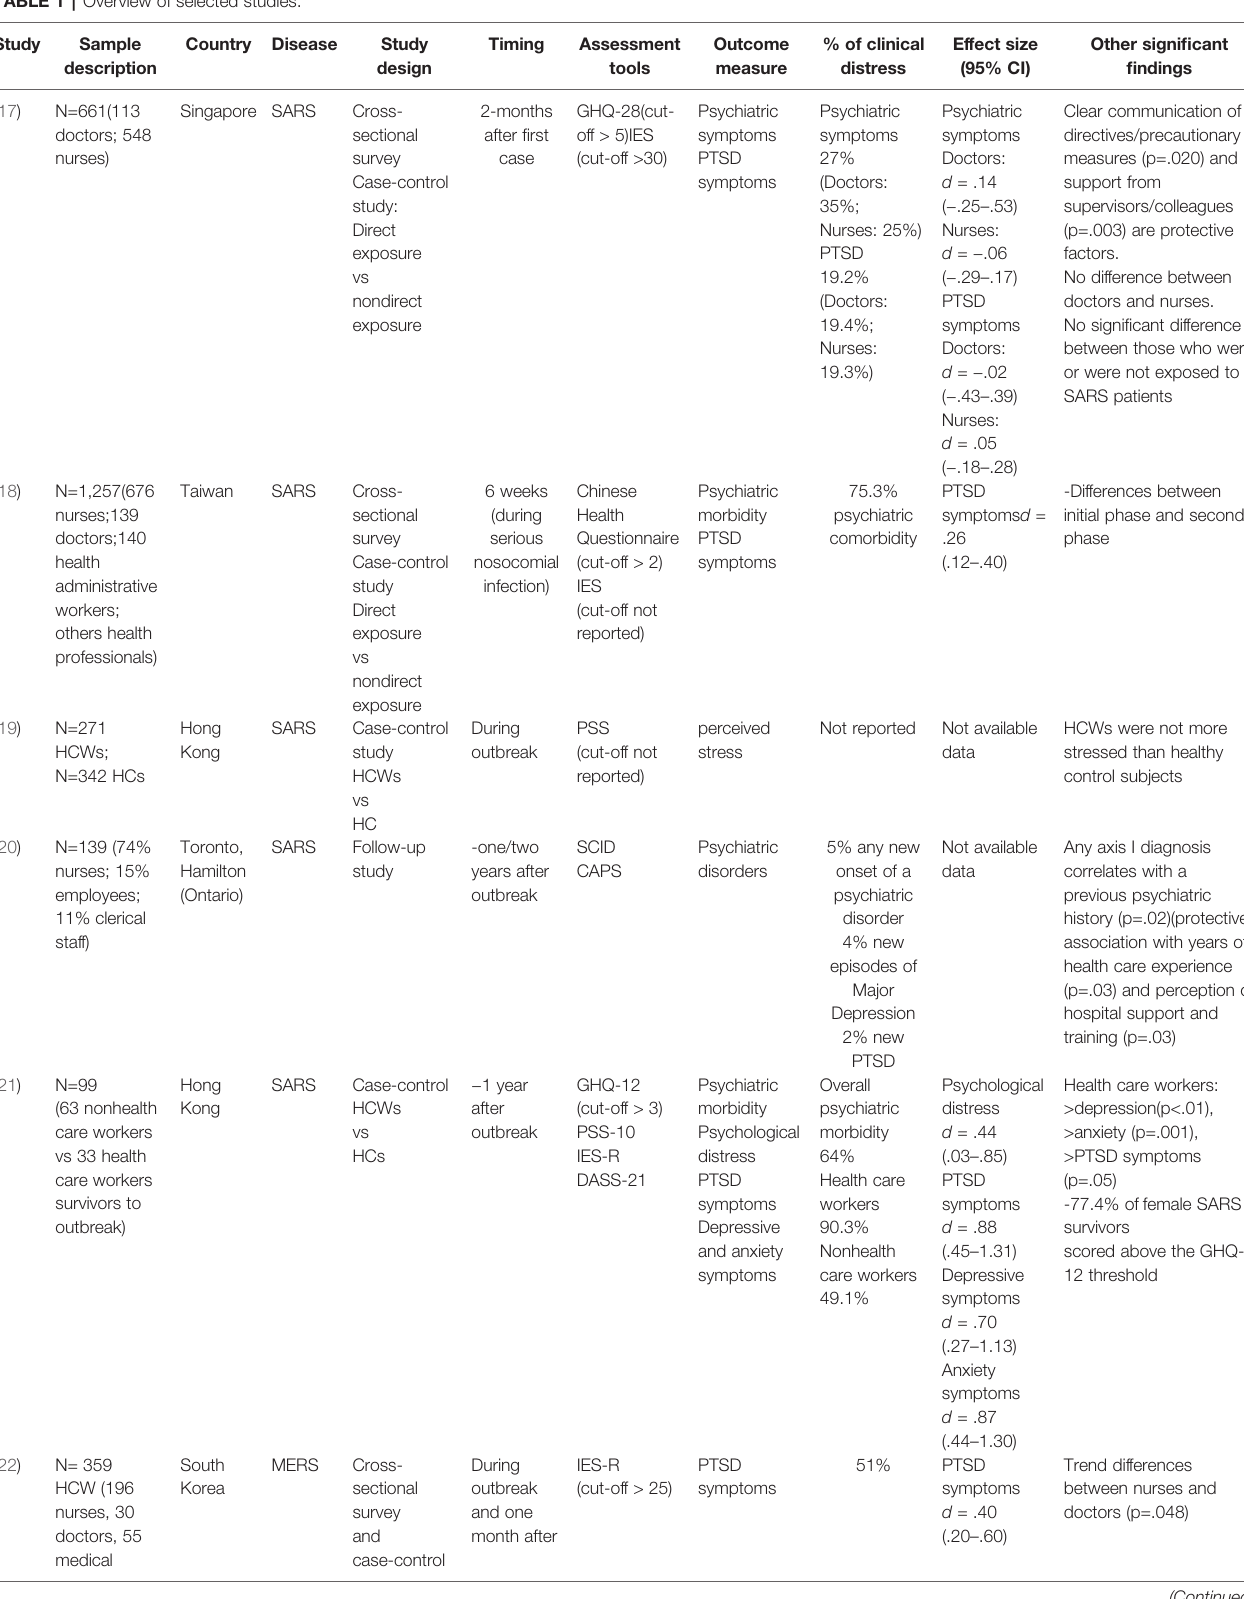
TABLE 1 | Overview of selected